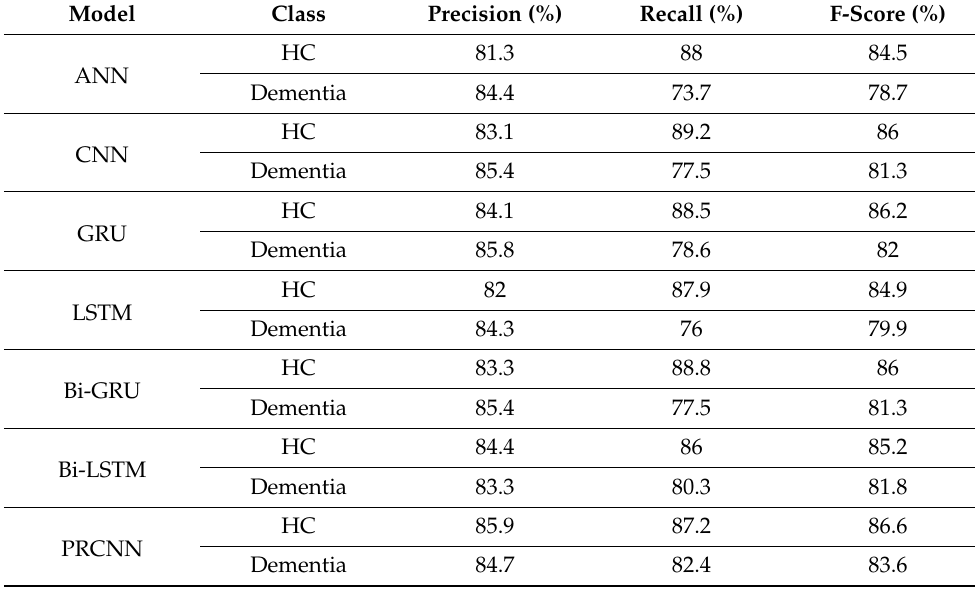
Table 3. Performance of DL